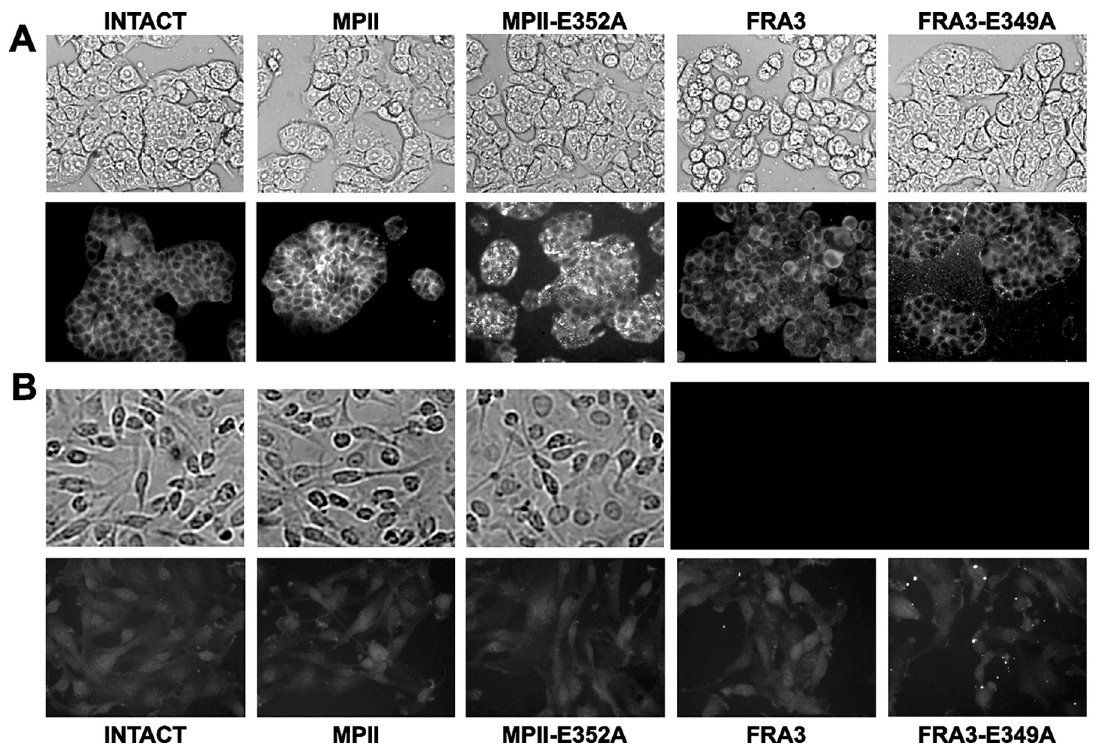
Fig 5. Immunostaining of cell-bound MPII. A , HT29 cells. B , U251 cells. Cells were left intact or incubated for 3 h at 37˚C with MPII, MPII-E352A, FRA3 or FRA3-E349A (5 µ g/ml, each). Cells were fixed, permeabilized and stained with the FLAG M2 antibody. Cell morphology was also observed using a bright-field microscope. The FRA3 and FRA3-E349A panels in Fig 5B are redacted as they partially overlapped and it was not possible to confirm which panel accurately presented the described results.